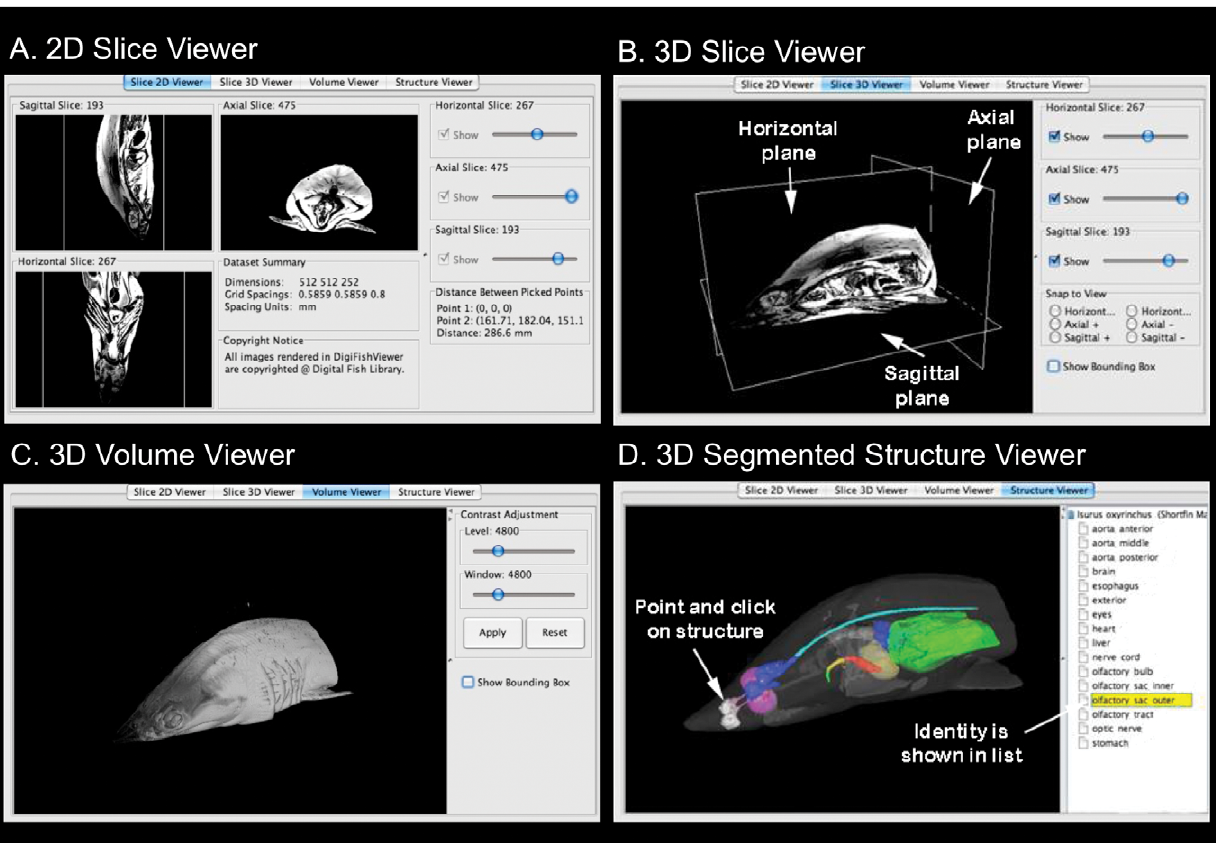
Figure 4. DigiFish Viewer with shortfin mako ( Isurusoxyrinchus ) MRI data. (A) 2D Slice Viewer displays slices in each orthogonal plane. Distances between points within slices can be measured. (B) 3D Slice Viewer displays an intersecting slice from each orthogonal plane in a single view that can be reoriented in 3D. (C) 3D Volume Viewer displays slice data as a 3D volume. Image contrast can be adjusted which also takes effect in the Slice Viewers. (D) 3D Segmented Structure Viewer displays 3D renderings of segmented structures. In this example, the skin (rendered partially transparent) and a selection of internal organs are shown. The olfactory sacs have been selected from the list of available structures and are highlighted (in white) in the viewer